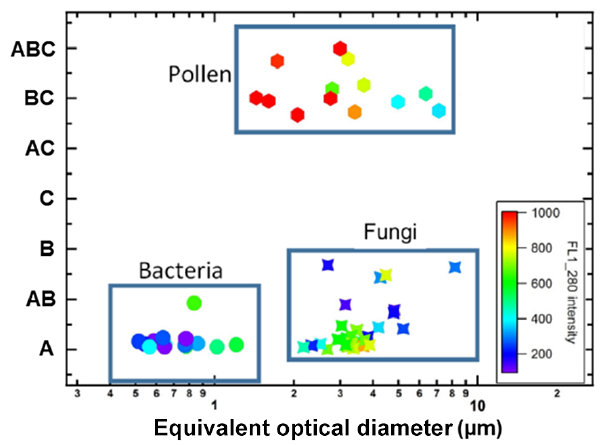
Figure 3. Assemblages of equivalent optical diameter and fluores- cence type from aerosolized pure cultures of bacteria ( • ), fungi spores ( X ) and pollen grains ( (cid:7) ) . The fluorescence type reported is a weighted composite of fluorescent type occurrence observed from each culture or pollen stock aerosolized; intensity is a relative